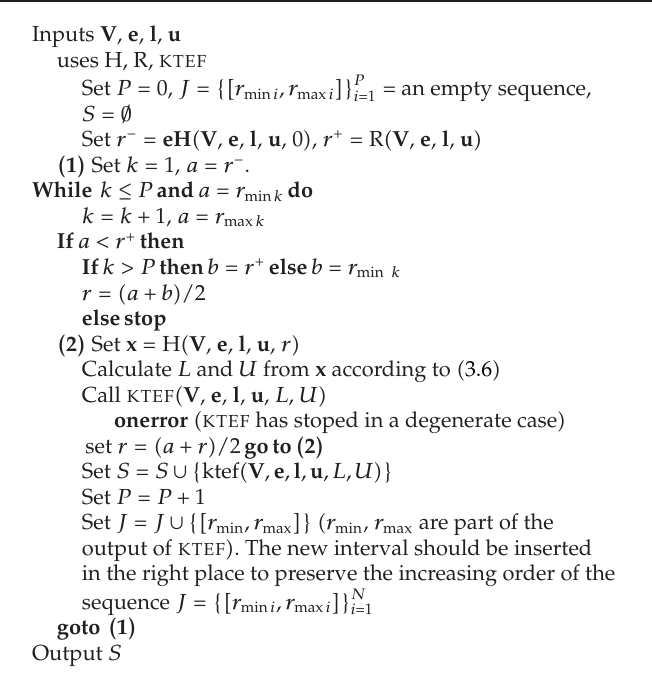
Algorithm 3: The KTEF - C